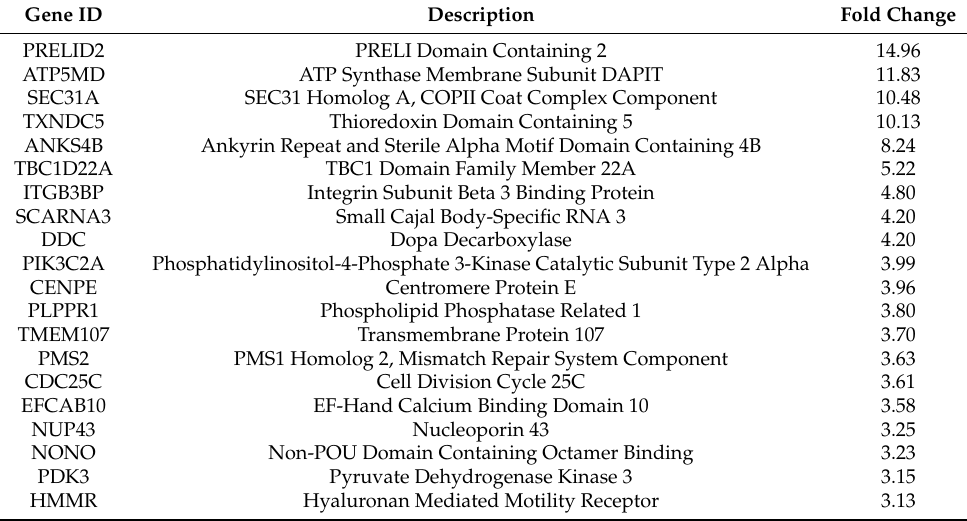
Figure 1. Expression of myc-tagged capsid proteins. A549 cells were transduced with lentiviral vectors expressing AcGFP alone or AcGFP and myc-tagged capsid proteins. Cells were collected at 48 h post-transduction for analysis by flow cytometry and immunoblotting. ( A ) GFP expression of transduced cells was measured by flow cytometry. Values shown are % GFP-positive cells relative to mock. ( B ) Cell lysates from duplicate samples were analyzed by immunoblotting with anti-Myc and anti-Actin. Table 1. List of top 20 downregulated differentially expressed genes ( p -value ≤ 0.01). Table 2. List of top 20 upregulated differentially expressed genes ( p -value ≤